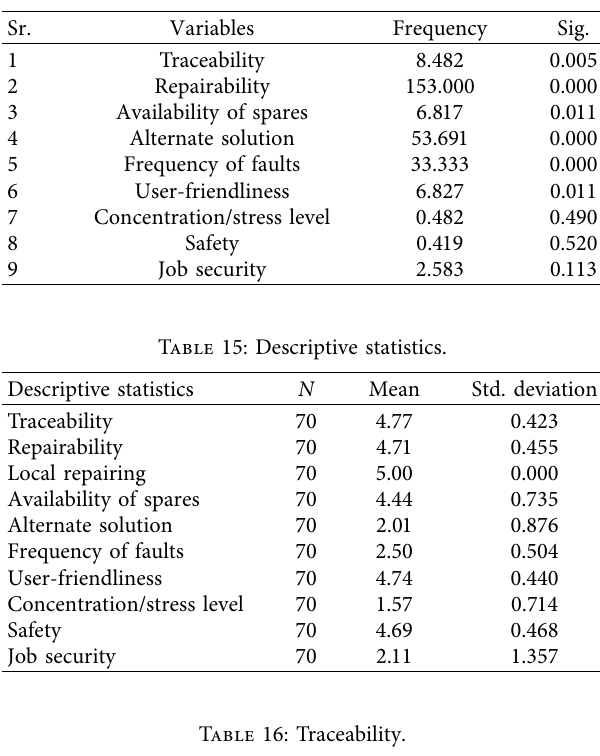
Table 14: Independent t -test.